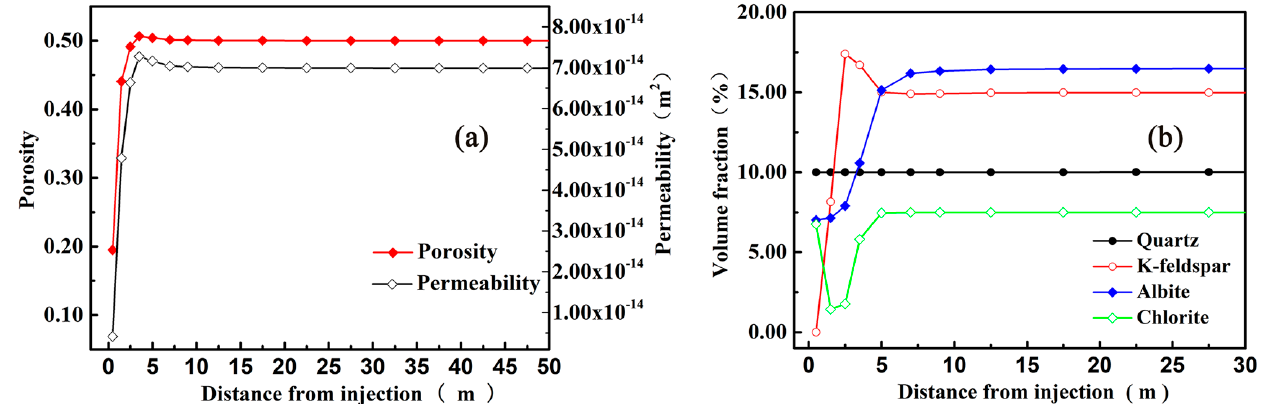
Figure 4. Simulation results at different distances from the injection point. ( a )—Porosity and perme- ability; ( b )—Content of primary minerals.